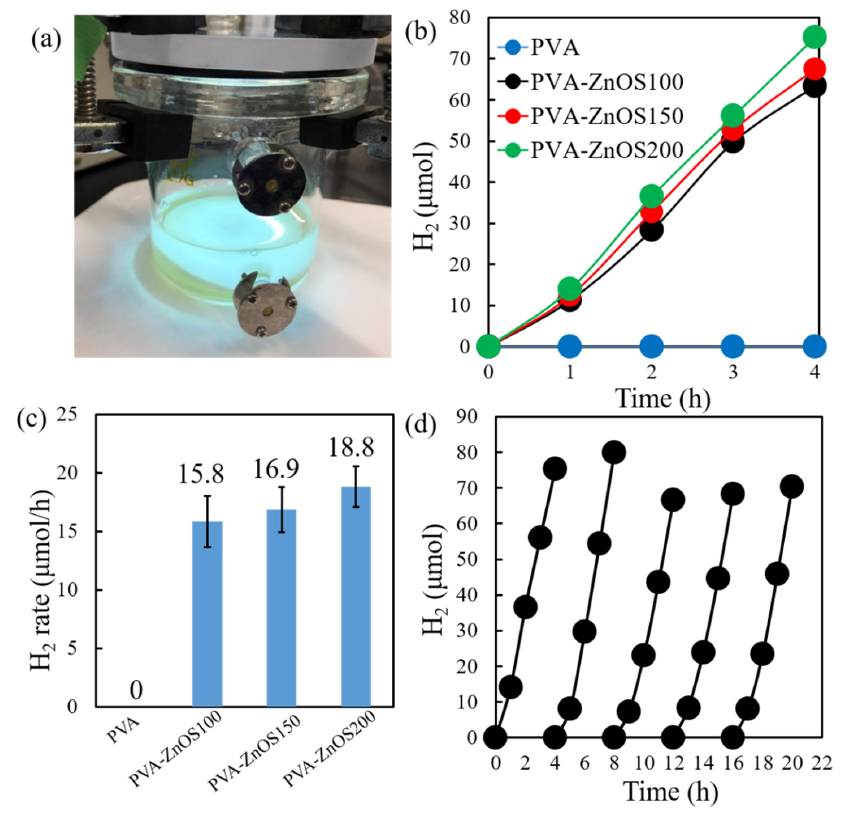
Figure 5. ( a ) Photograph of photocatalytic ‐ reactor ‐ contained PVA ‐ ZnOS gel under UV radiation; ( b ) H 2 generation as a function of radiation time from pure PVA and PVA ‐ ZnOS; ( c ) average production rate of H 2 of all samples; ( d ) Recycling test performed with PVA ‐ ZnOS200.